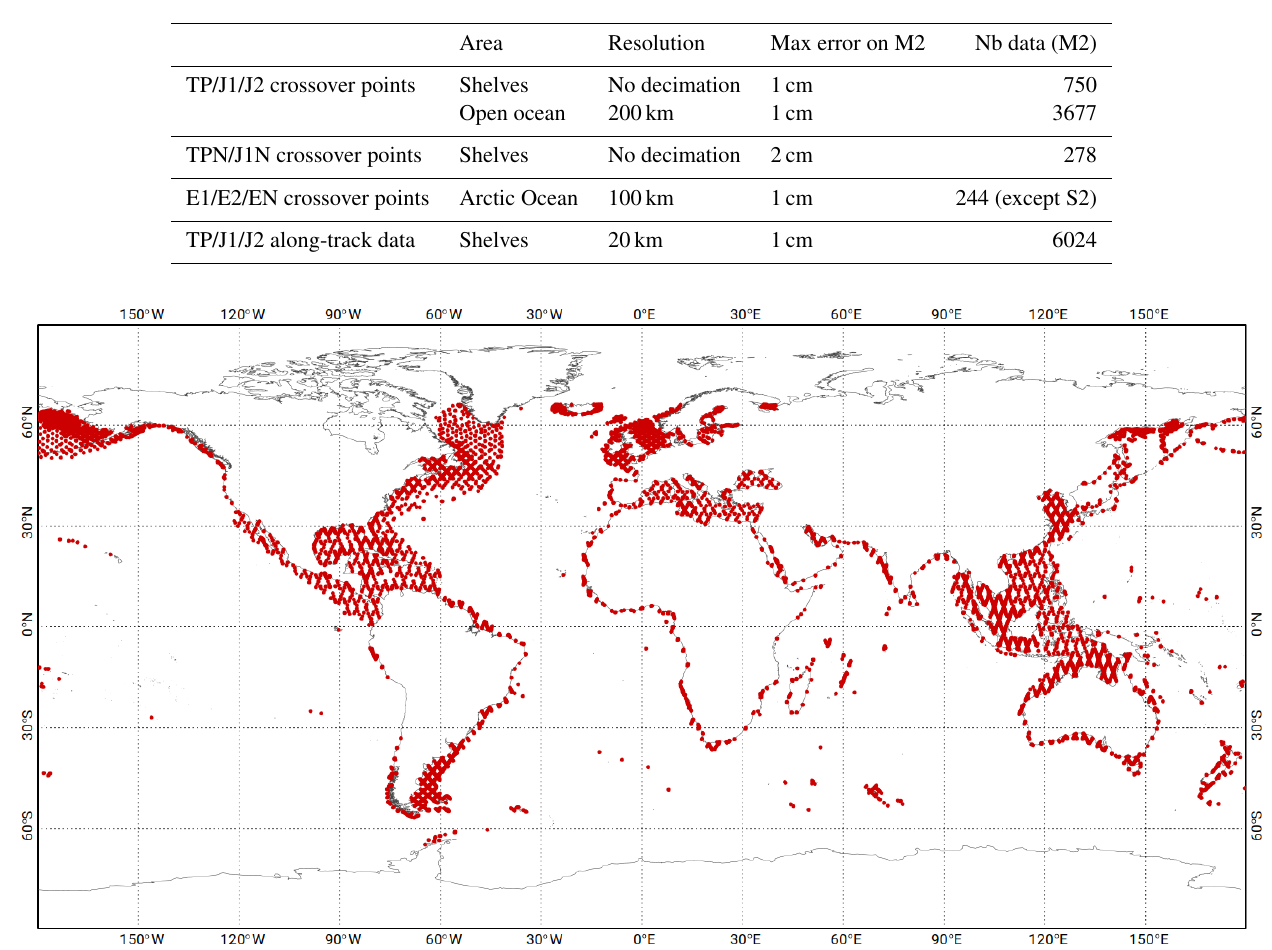
Table 4. Selection criteria of the altimetry observations for the data assimilation process, depending on the mission. Deep/shelf limit indicates the 500m isobaths. “Arctic Ocean” denotes seas located over the 60 ◦ N limit. The harmonic data error is computed from an estimate of the non-tidal ocean dynamics contamination. It is estimated by looking at sea surface signal spectral energy close to the considered constituent’s aliased frequency.